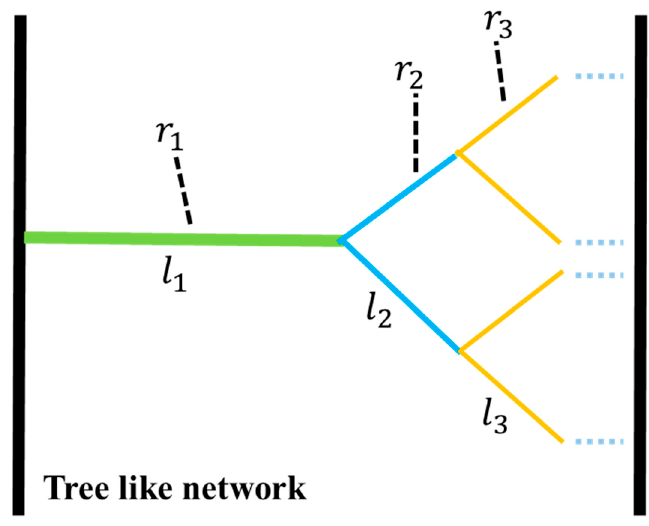
Figure 1. Y-shaped branching model.